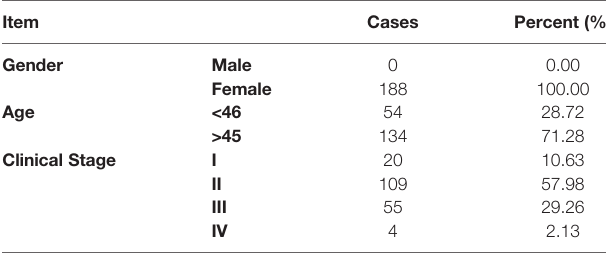
TABLE 1 | Summary of 188 luminal-b breast cancer samples.